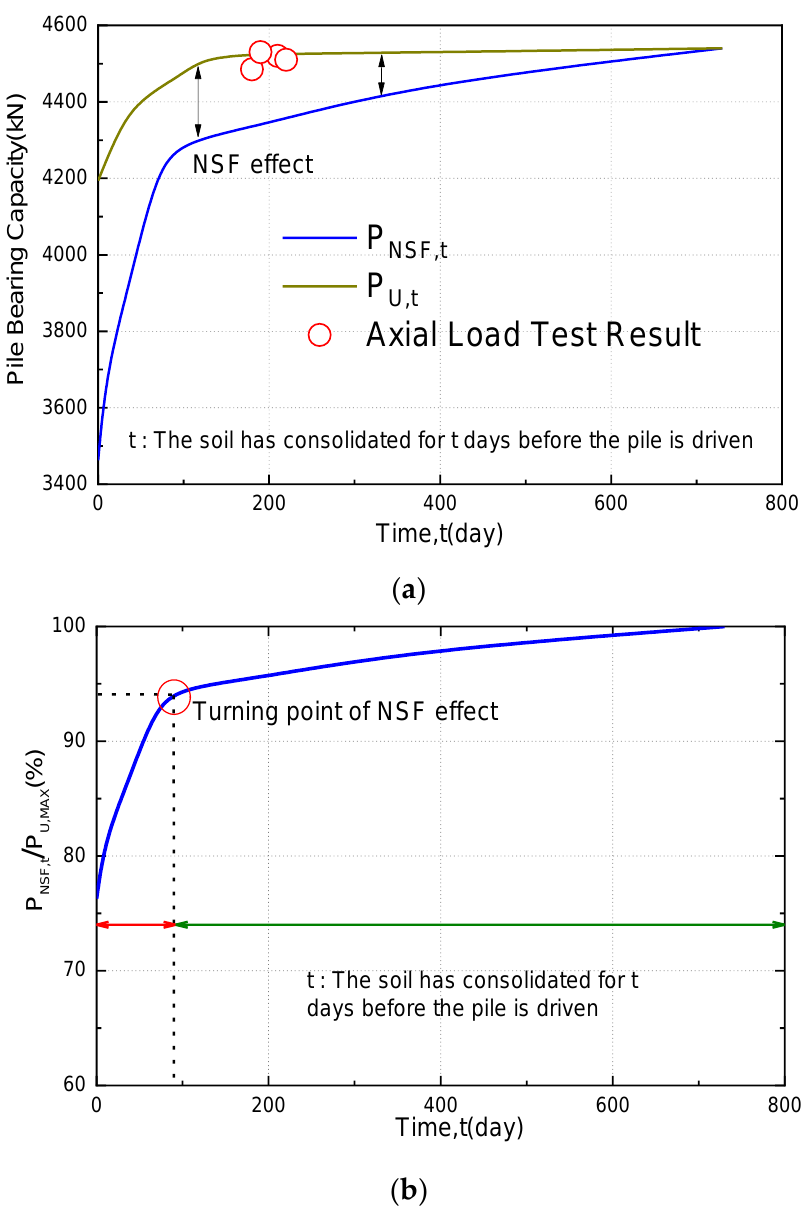
Figure 10. Bearing capacity of pile foundation when driving pile after different consolidation times.